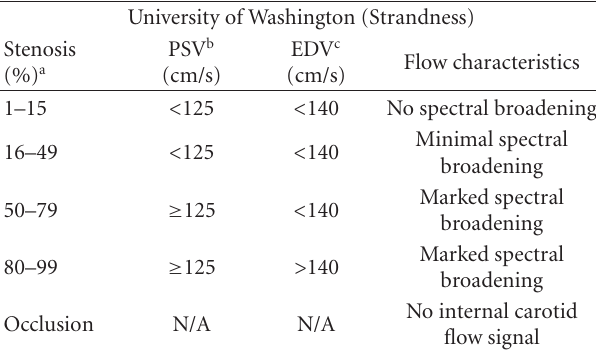
Table 1: University of Washington criteria [19].